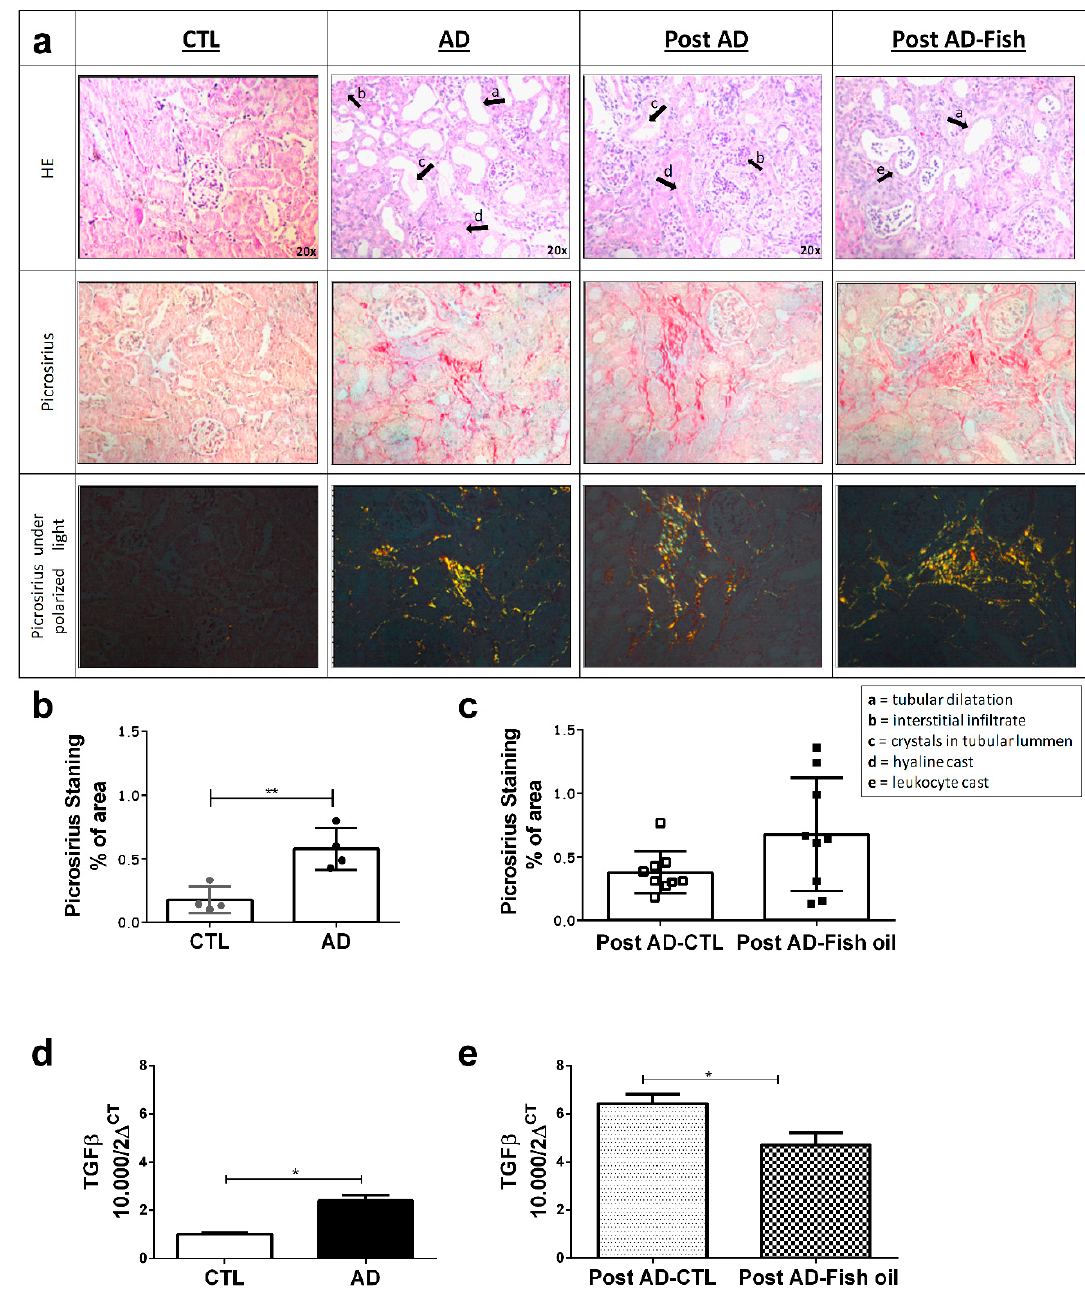
Figure 5. Fibrosis evaluation through picrosirius and transforming growth factor beta (TGF β ): ( a ) Images from Hematoxylin and eosin (HE) stain and picrosirius the kidney samples of CTL/AD and Post AD-CTL and Post AD-Fish oil groups. Graphical quantification of fibrosis observed by picrosirius in ( b ) CTL/AD and ( c ) Post AD-CTL and Post AD-Fish oil groups. TGF- β expression in ( d ) CTL/AD and ( e ) Post AD-CTL and Post AD-Fish oil groups (* p < 0.05, ** p < 0.01).